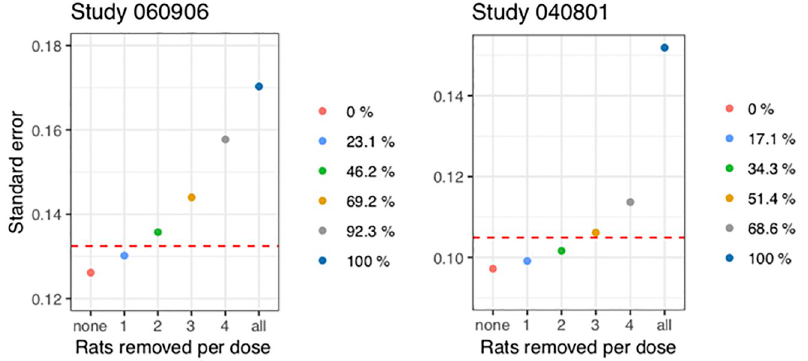
Fig 5. Standard error for the relative log-potency based on 1000 simulations for the two studies. The red dotted line is the standard error on the parameter from re-fitting the simulated data using the standard approach. The points indicate the re-fits using the mixed-effects meta-analysis approach, removing different numbers of control rats. On the x-axis, the number of control rats removed per dose is seen, and the legend shows the resulting reduction in percent of the total number of control rats.